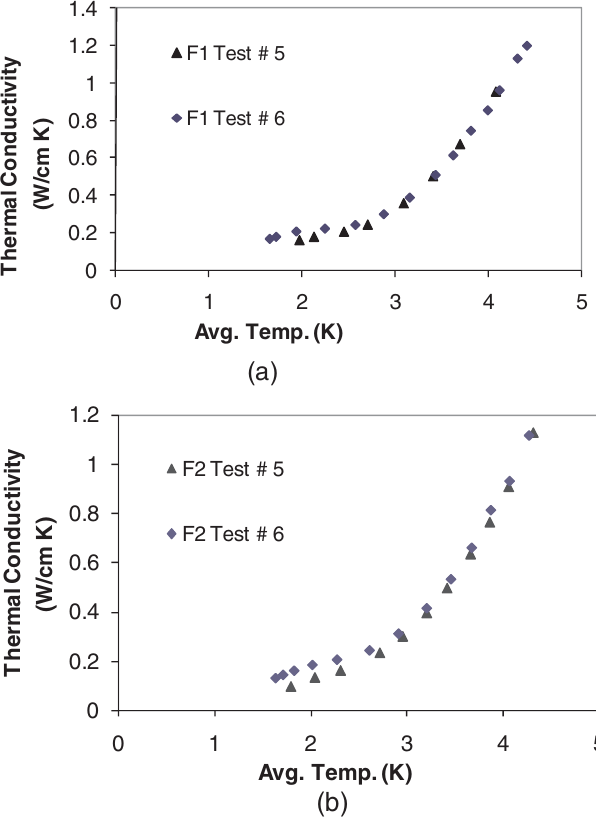
FIG. 9. (a),(b): The low temperature heat treatment (test #6) has slightly increased the thermal conductivity of flat samples in the phonon conduction regime (below 3 K), from their previous values in test #5 on the as-received samples.